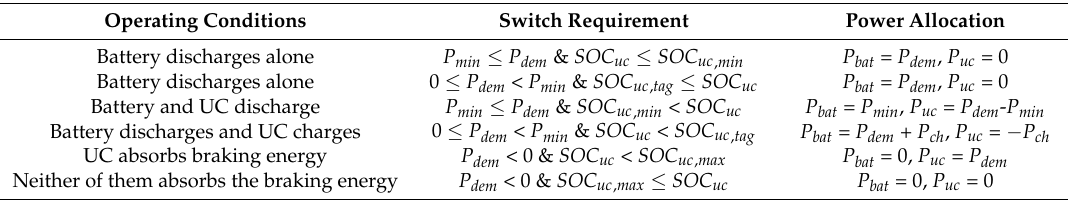
Table 7. Traditional rule-based controller.